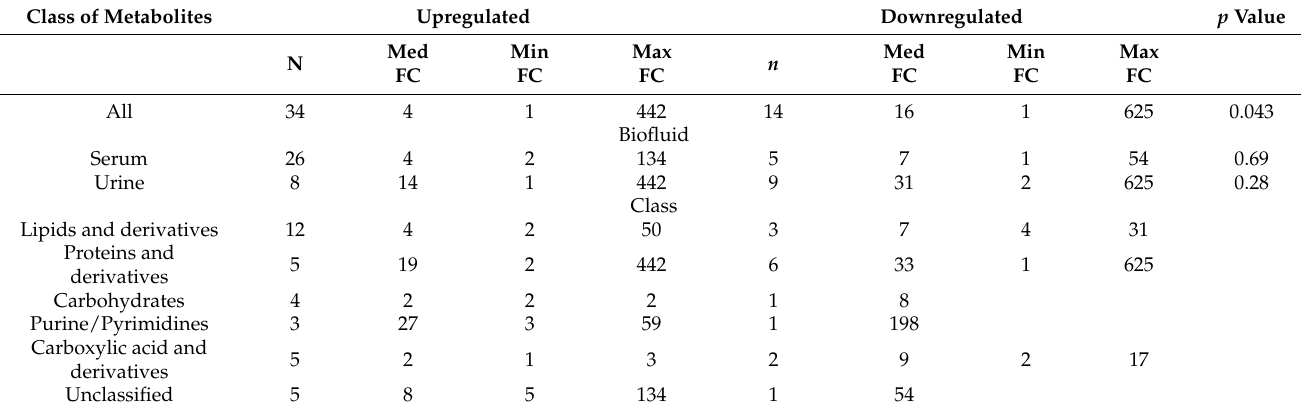
in the urine samples, the median FC change was 14 and 31, respectively ( p = 0.28). The maximum FC for upregulated metabolites in the serum and urine samples was 134 and 442, respectively. The maximum FC for downregulated metabolites in the serum and urine samples was 54 and 625, respectively. Purines/pyrimidines and proteins and derivatives had a larger dysregulation than those in the other classes of metabolites ( p = 0.045 and p = 0.027, respectively). Purines/pyrimidines had the highest median FCs of 27 and 198, respectively, for up- and downregulated metabolites, followed by proteins and derivatives with median FCs of 19 and 33, respectively. The median FCs for lipids were 4 and 7 for up- and downregulated metabolites, respectively. Both carbohydrates and carboxylic acid and derivatives had a median FC of 2 for upregulated metabolites; for downregulated metabolites in these categories, the median FC was 8 for carbohydrates and 9 for carboxylic acid and derivatives. For the unclassified metabolites, the median FC was 8 and 54 for the upregulated and downregulated metabolites, respectively. These results are summarized in Figure 3. Table 4. Fold change (FC) in metabolites post-surgery based on biofluid and chemical class. Class of Metabolites